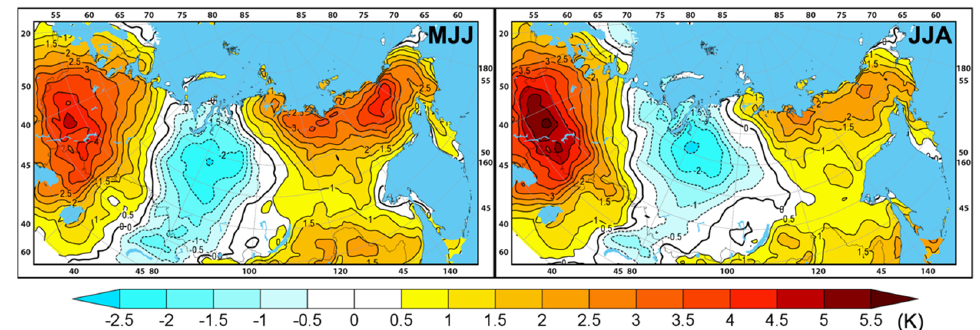
Figure 3. Spatial distributions of mean SAT anomalies in MJJ and JJA in 2010 with the E → L transitions from ERA-Interim reanalysis data.